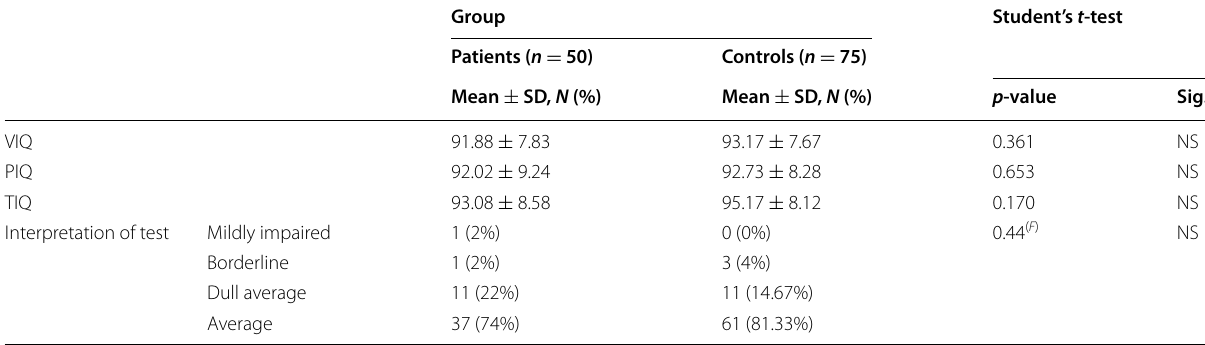
Table 1 Comparative analysis of intelligence quotient test